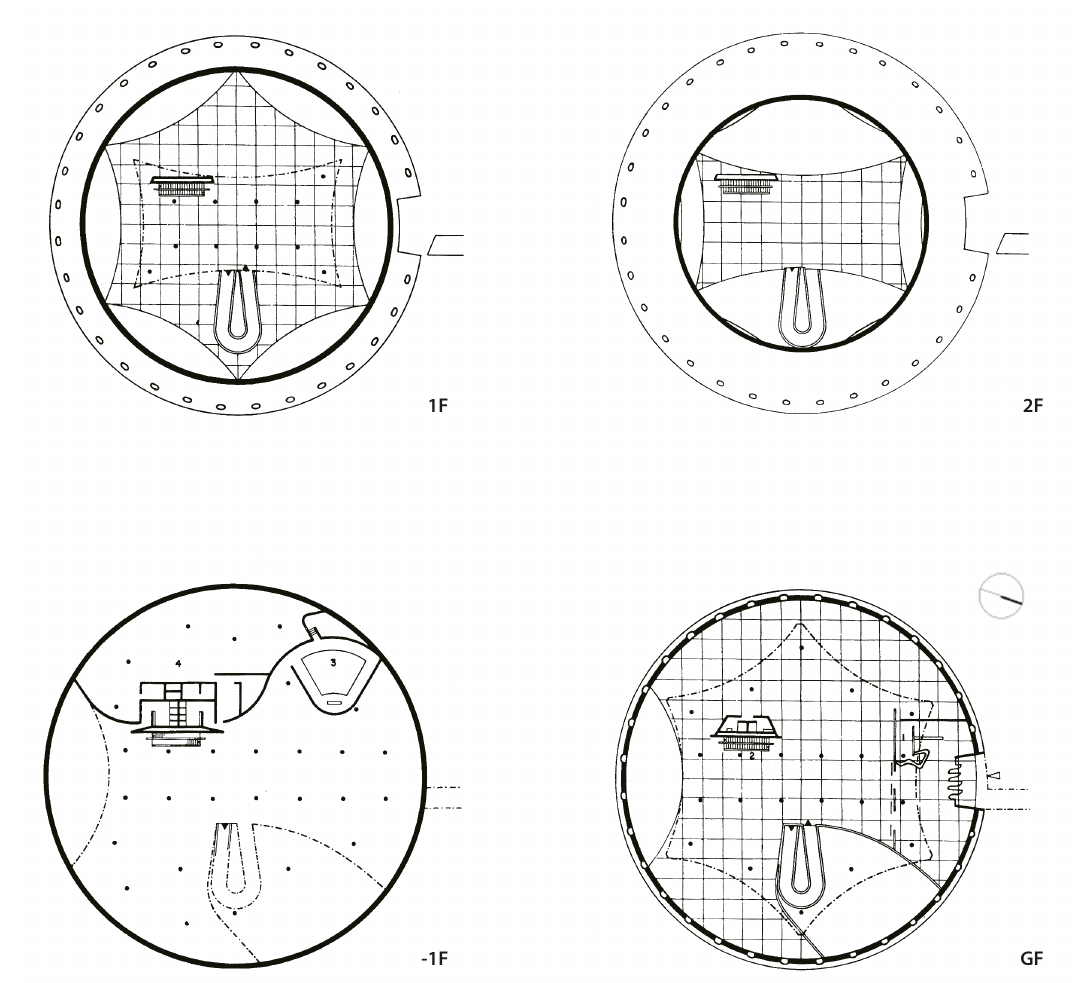
5a-1F1F Figure 5a Oscar Niemeyer, original plans of Palace of Arts (Oca). (Source: Mindlin 1956, 188).